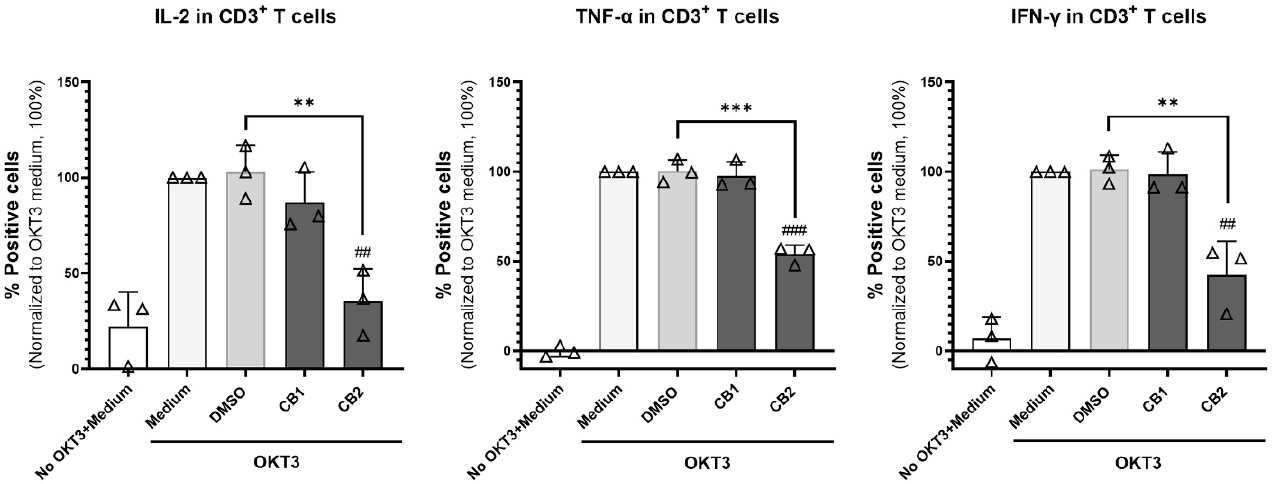
Figure 5. Effect of CB1 and CB2 agonists on cytokine production of T cells. PBMCs (n = 3) were activated with anti-CD3 mAb OKT3 and anti-CD28 mAb in the presence of 20 µ M CB1 agonist ACEA or CB2 agonists GW833972A and the results compared with those of the relevant concentration of DMSO or medium control for 6 h. The percentage of cytokine positive cells (% specific marker mAb staining–% isotype-matched control mAb staining) as indicated was determined in the CD3 + T cell population by intracellular staining and flow cytometry. The bar graphs report the percentage of cytokine positive cells under the indicated conditions as mean ± SD. A triangle represents an individual datum. Each individual datum was normalized relative to its medium control (OKT3 + Medium) as 100%. We used unpaired t -test for comparison of the DMSO control with the tested conditions. ** p < 0.01; *** p < 0.001. We used unpaired t -test to compare the medium control and the tested conditions. ## p < 0.01; ### p <